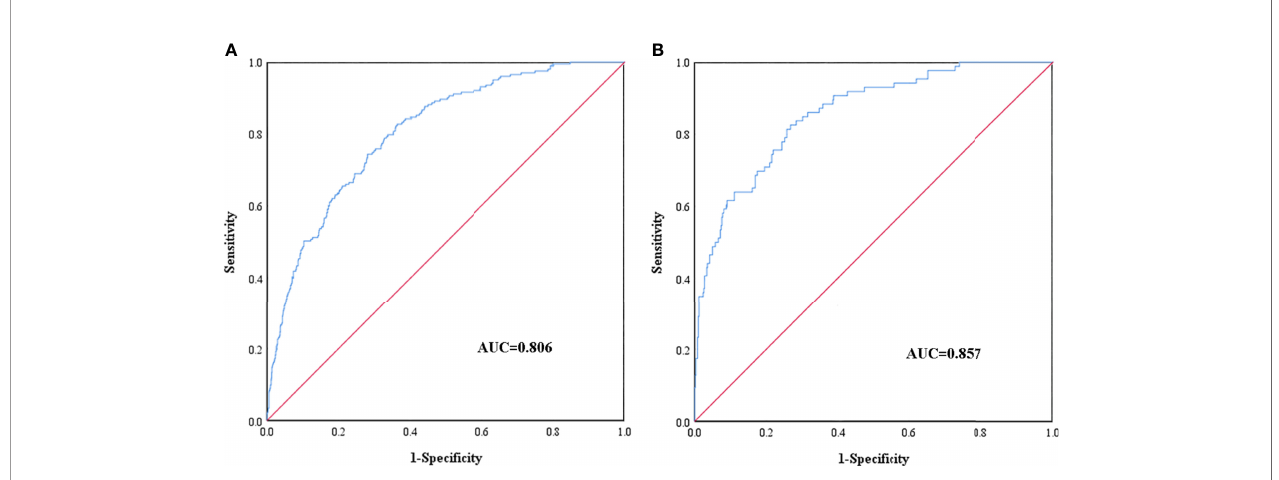
FIGURE 3 | ROC curves of the nomogram prediction for the risk of diabetic foot in patients with T2DM in the training cohort (A) and validation cohort (B)